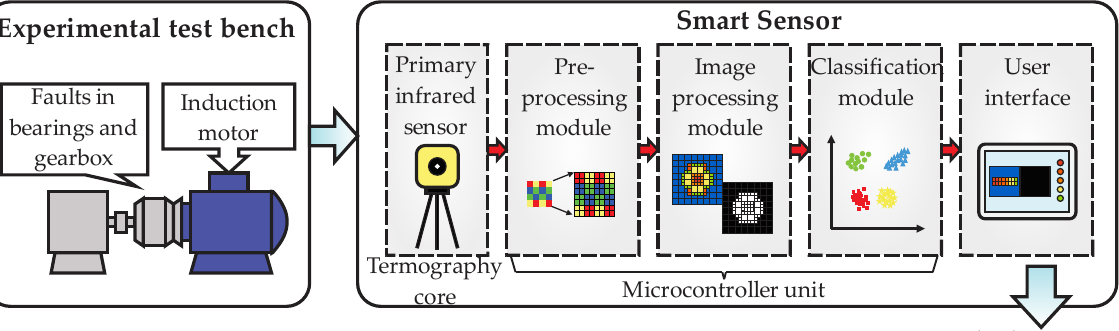
Figure 1. Block diagram of the general structure of the smart sensor for fault diagnosis based on infrared thermography.